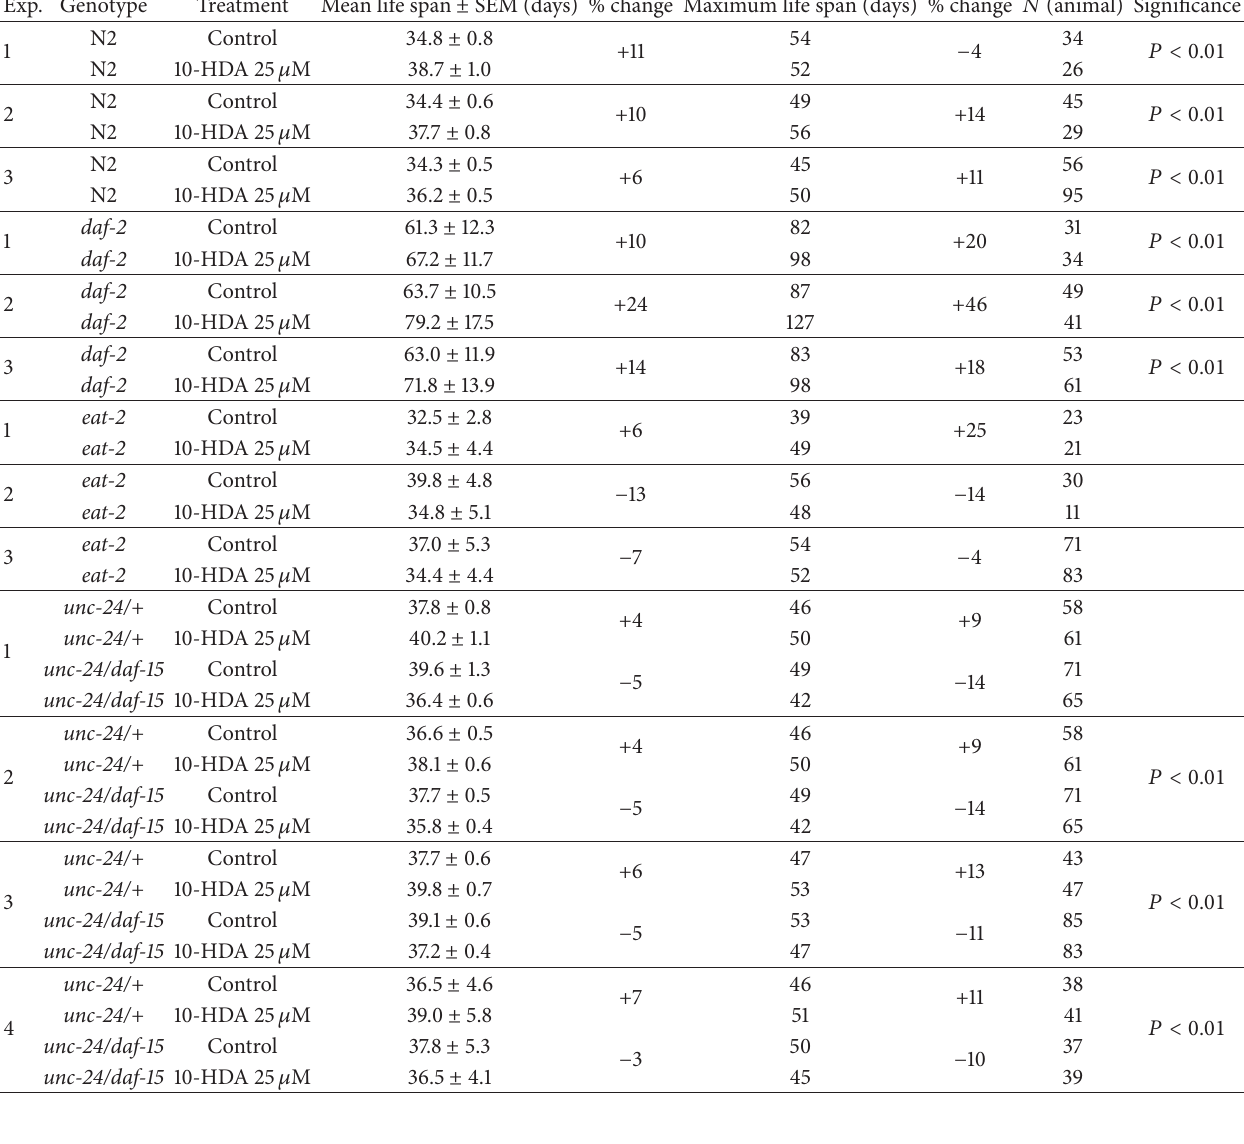
Table 1: The effects of 10-HDA on the lifespan of various mutants. Exp. Genotype